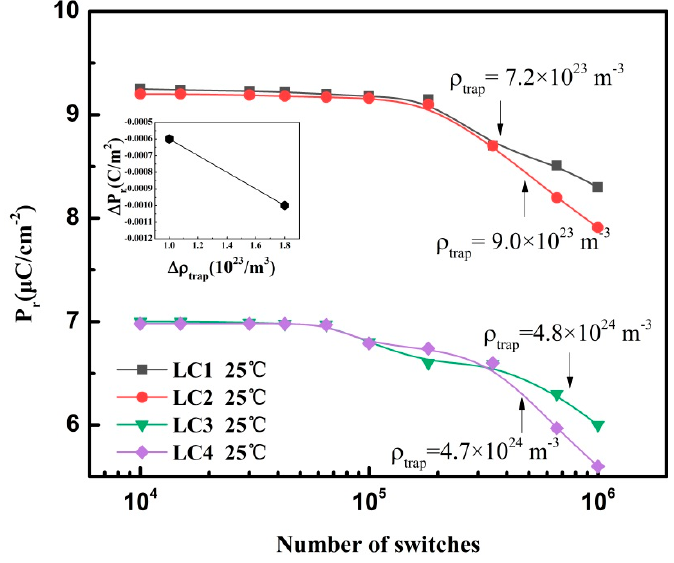
Figure 3. Polarization fatigue properties of LC1–LC4 with different trapped charge densities at 25 °C. The inset in the top left corner shows the linear relationship between trapped charge density and remanent polarization.